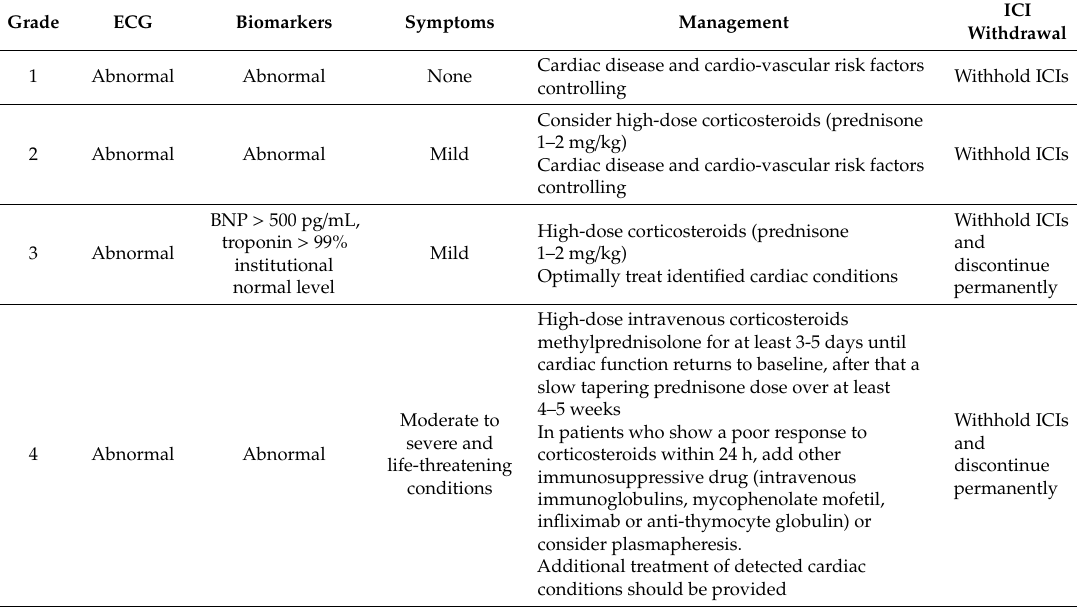
Table 3. Management of immune checkpoint inhibitor-associated cardiotoxicity (modified according to Brahmer et al. [70], Puzanov et al. [32], Haanen et al. [91], and Thompson et al.